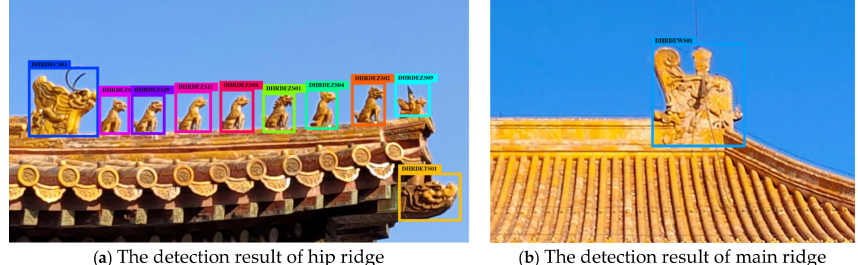
Figure 11. The roof detection result based on You Only Look Once v3 (YOLOv3)